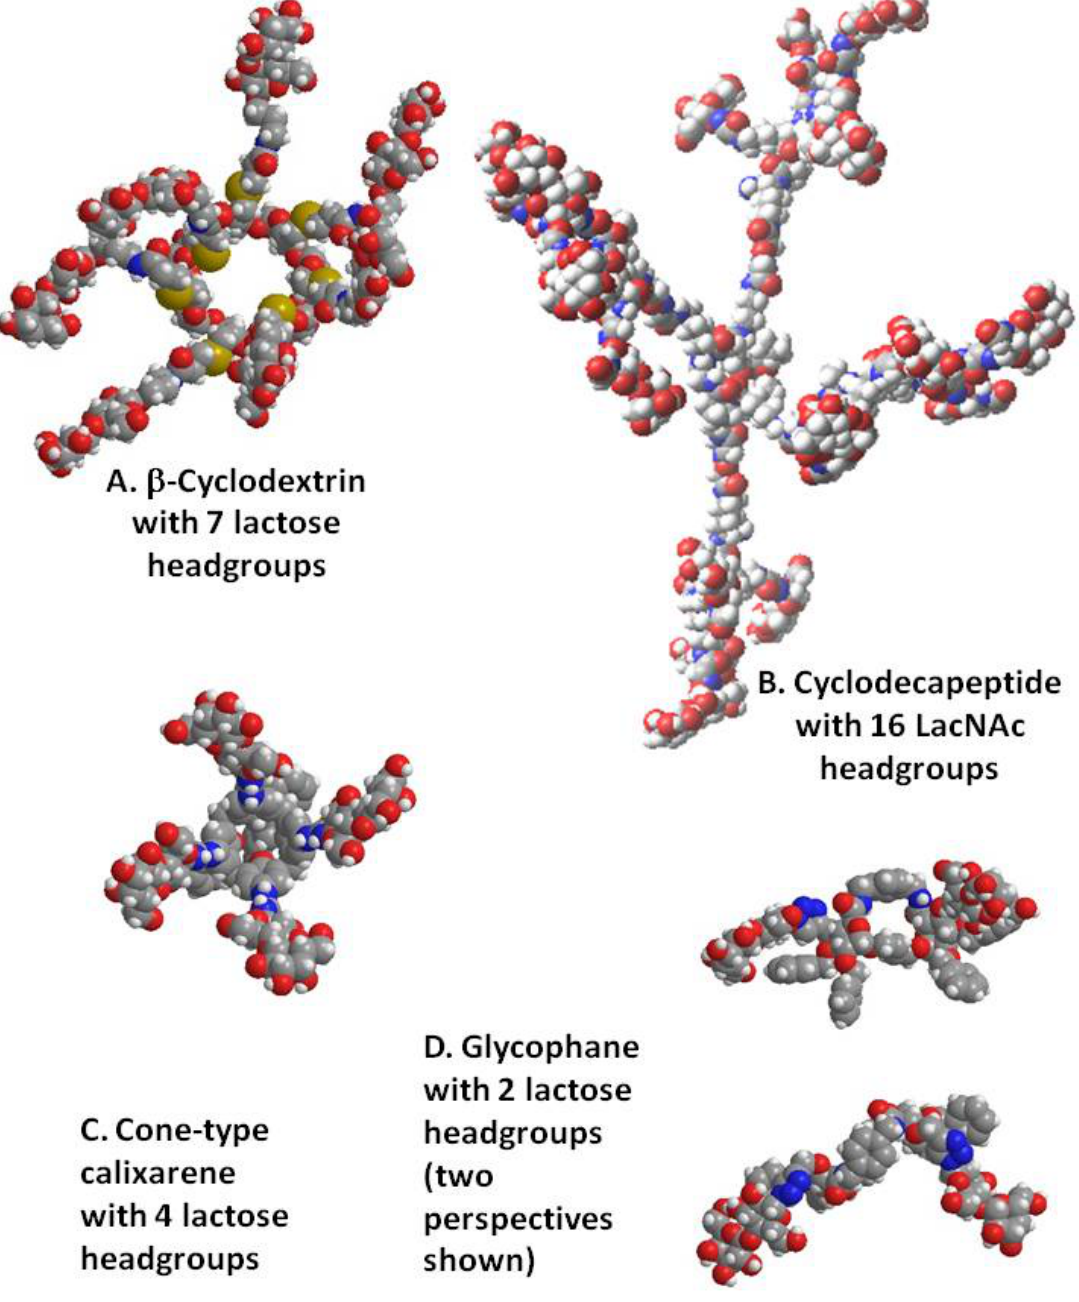
Figure 3. Schematic illustration of the structures of four cyclic scaffolds tested for galectin reactivity, i.e. ,  -cyclodextrin, cyclic decapeptide, cone -type calixarene and